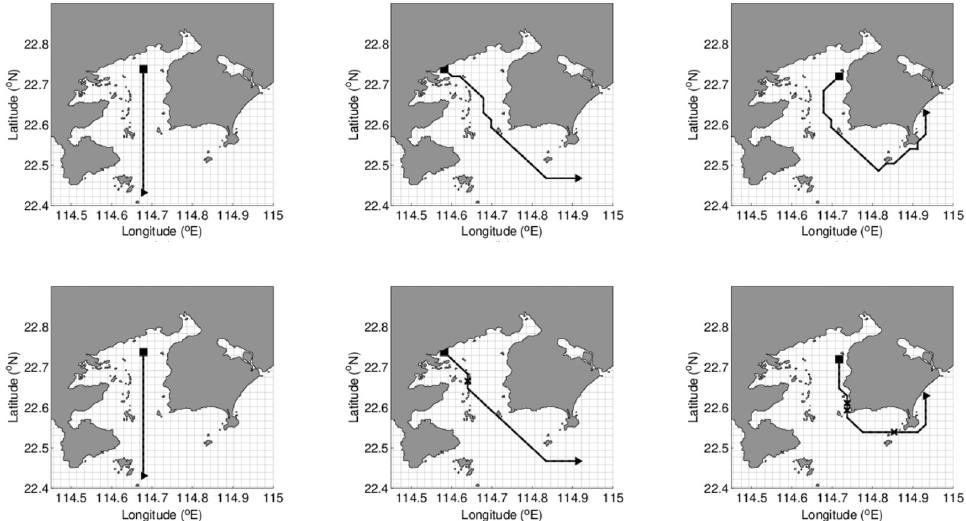
Figure 7. The comparison of the optimal paths with ( top ) and without ( bottom ) consideration of steady ocean currents is shown in Figure 4. The AUV moves against the ocean current. The symbol ‘×’ indicates where the AUV stops moving forward because it cannot overcome the counter-current. The panels from left to right are for Cases 1, 2, and 3.